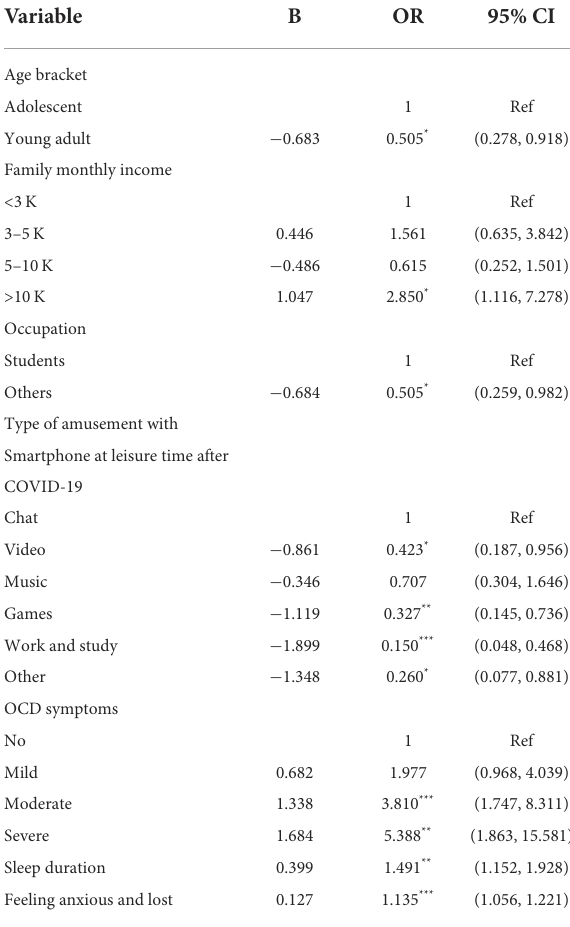
TABLE 2 Variables associated with non-suicidal self-injury (NSSI) behaviors in the model of binary logistic